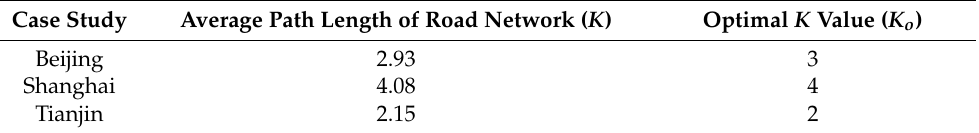
Table 5. Statistics of optimal K value and average path length of road network in different study areas. Case